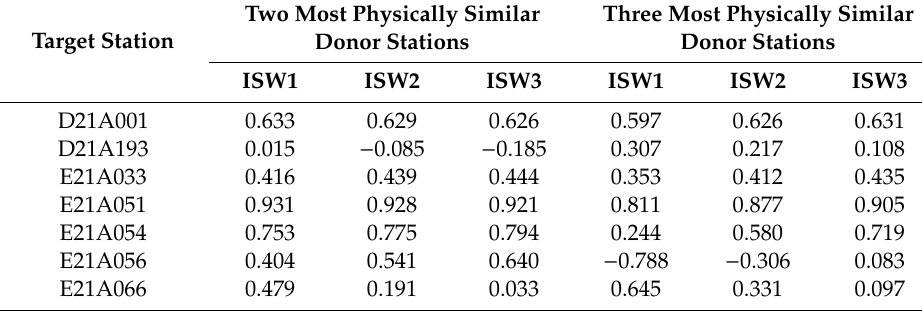
Table 13. NSE values for ISW with powers of 1, 2, and 3 in the Upper Euphrates Basin. Target